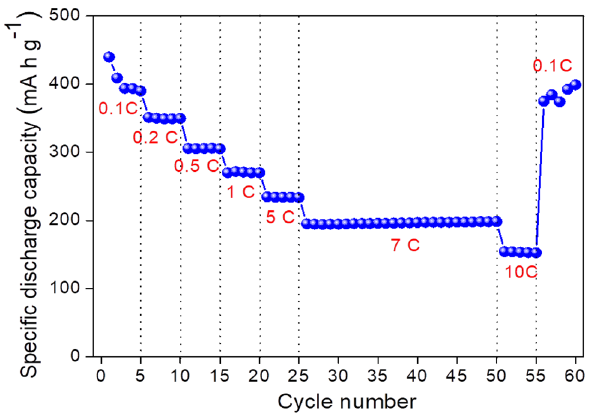
Fig. 10 Rate capability of B-TiO